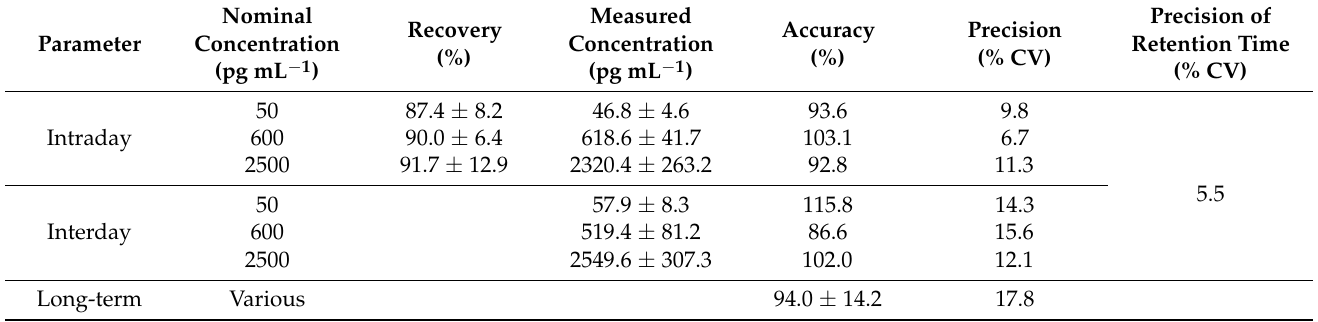
Table 2. Parameters of variability and extraction recovery for at RA. Intra- and interday accuracy/precision and extraction efficiency based on recovery of at RA-d5. Accuracy is the mean of quantified concentration given as percentage of three spiked concentrations (nominal) in human artificial plasma samples. Precision is the coefficient of variation (CV) of mean concentration determined for three different concentration levels (intra/interday, n = 4). The precision of retention time is described as the CV of the mean retention time of 120 injections (21 calibrators, 99 samples) over a period of 65 days. Long-term accuracy and precision were determined over a period of 30 days with 105 injections of varying concentration within the calibration